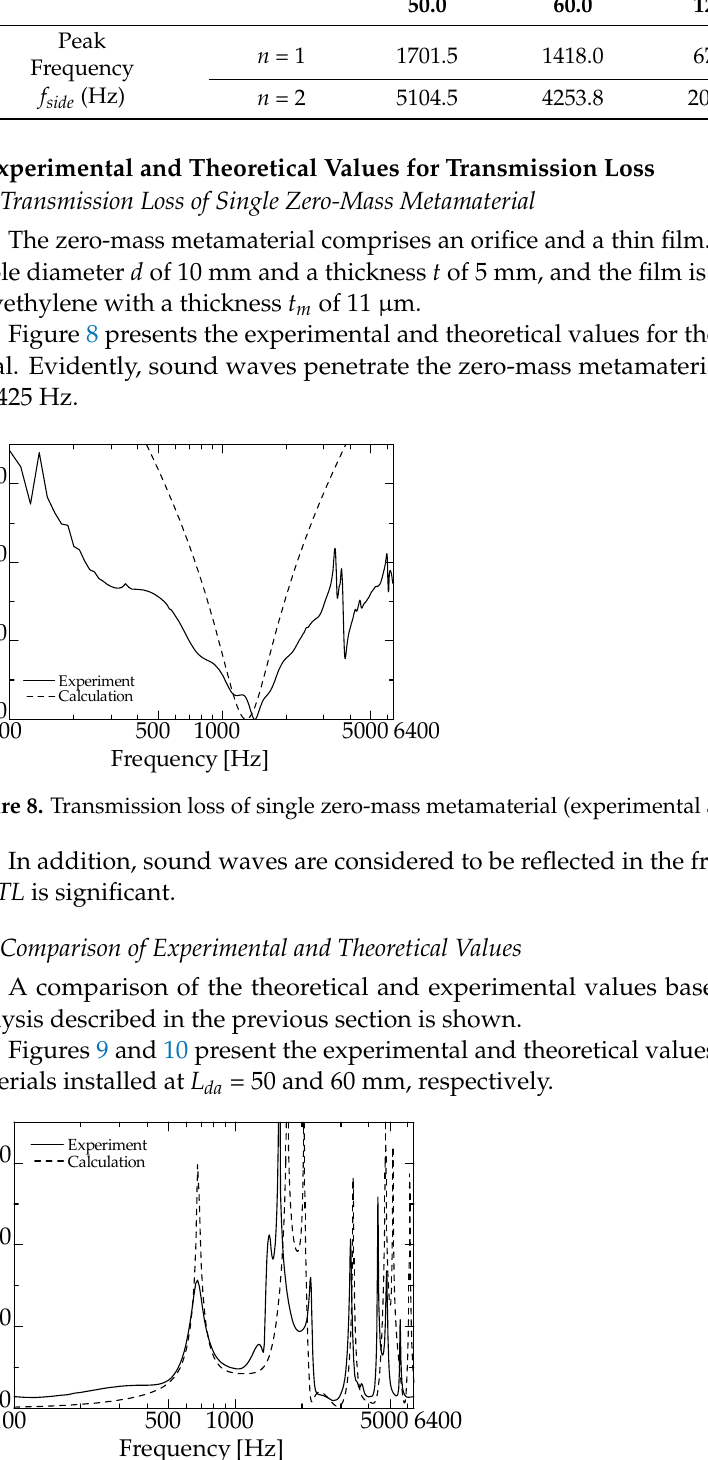
Figure 9. Experimental and theoretical values of the interference silencer with incorporated zero-mass metamaterial (zero-mass metamaterials installed at L da = 50 mm).